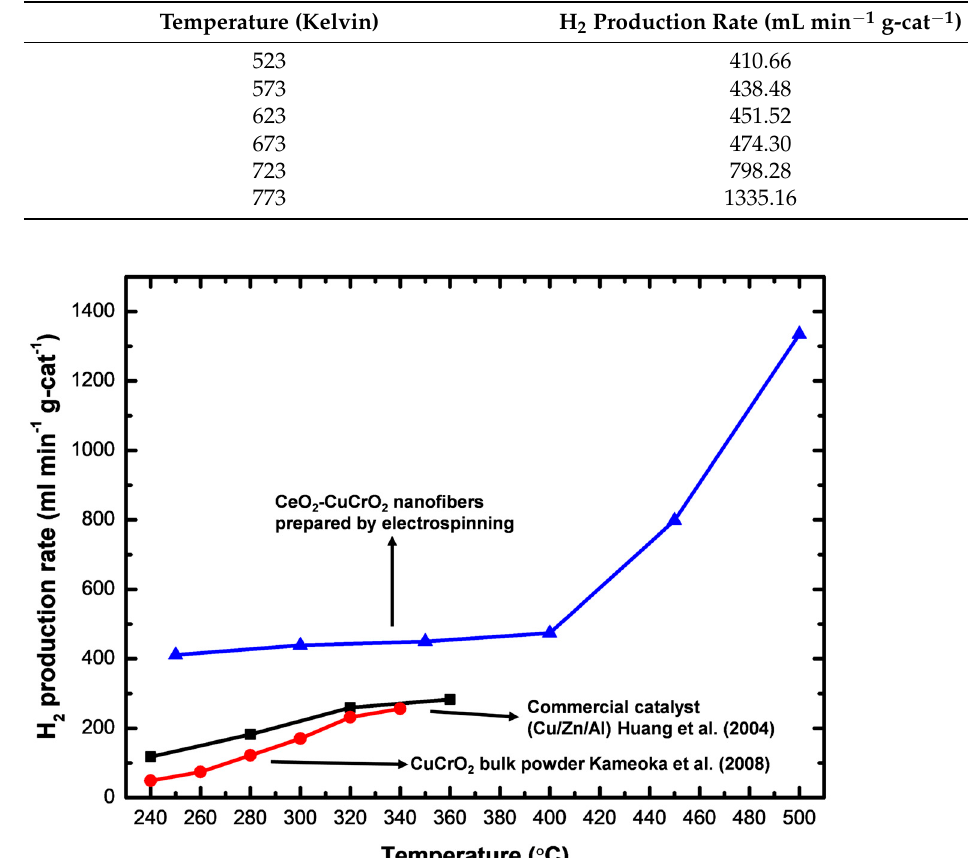
Figure 10. Hydrogen production of electrospinning prepared CeO 2 -CuCrO 2 , compared with Cu- (solid-state method) [24] and commercial Cu/Zn/Al catalysts CrO 2 (solid-state method) [24] and commercial Cu/Zn/Al catalysts [35]. Table 2. Hydrogen production rate of CeO 2 -CuCrO 2 nanofibers at different temperatures.